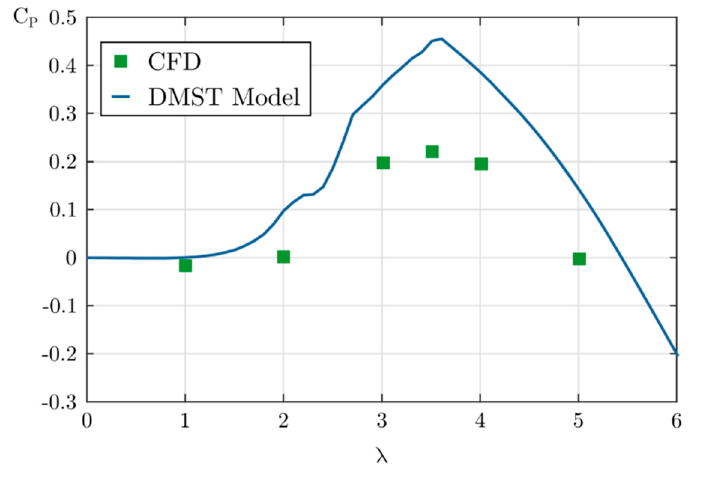
Figure 3. Predicted power curve with the DMST model and CFD